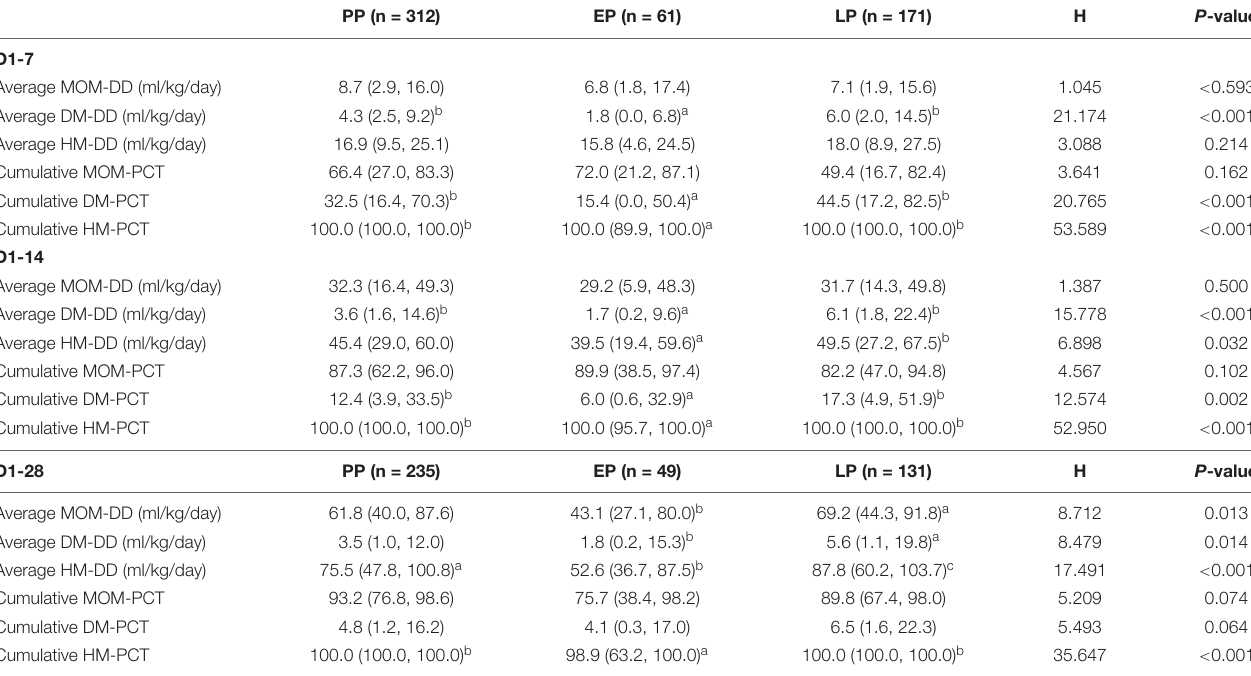
TABLE 4 | Comparison of quantitative feeding indicators for preterm infants in NICU hospitalization: amount and rates.